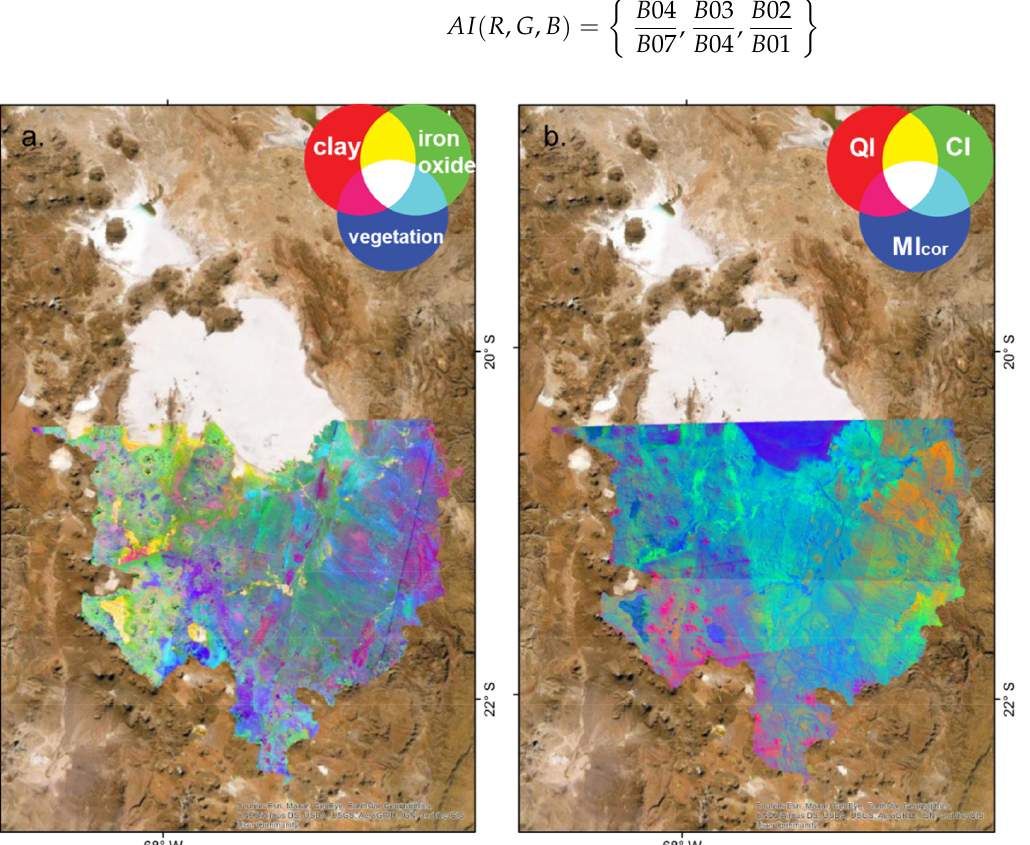
Figure 5. Spectral index maps developed over the study area. ( a ) SWIR Abrams ratio. RGB image channels are clay (R), iron oxide (G), and vegetation (B). ( b ) TIR index combination. RGB image channels are Quartz Index (QI) (R), Carbonate Index (CI) (G), and Mafic Index corrected (MIcor)